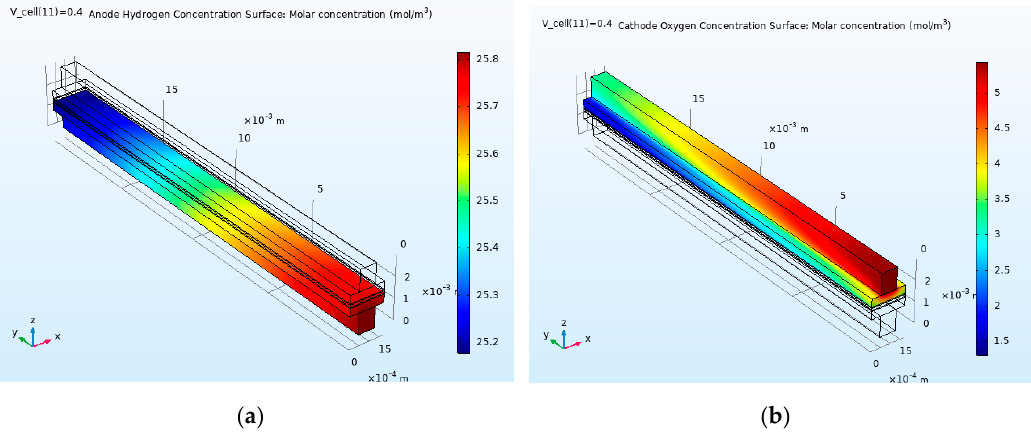
Figure 6. Concentration of ( a ) the hydrogen along the anode flow channel and ( b ) the oxygen along the cathode flow channel operating at 180 °C and 0.4 V (mol/m 3 ).